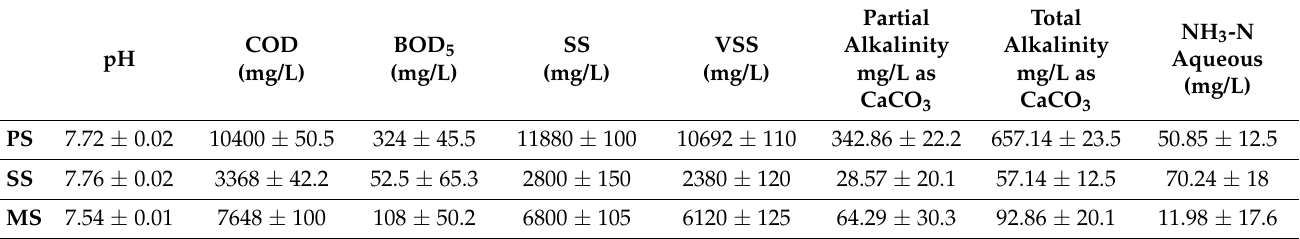
Table 1. Characteristics of Primary Sludge, Secondary Sludge and Mixed Sludge (The results are average and standard deviation of 3